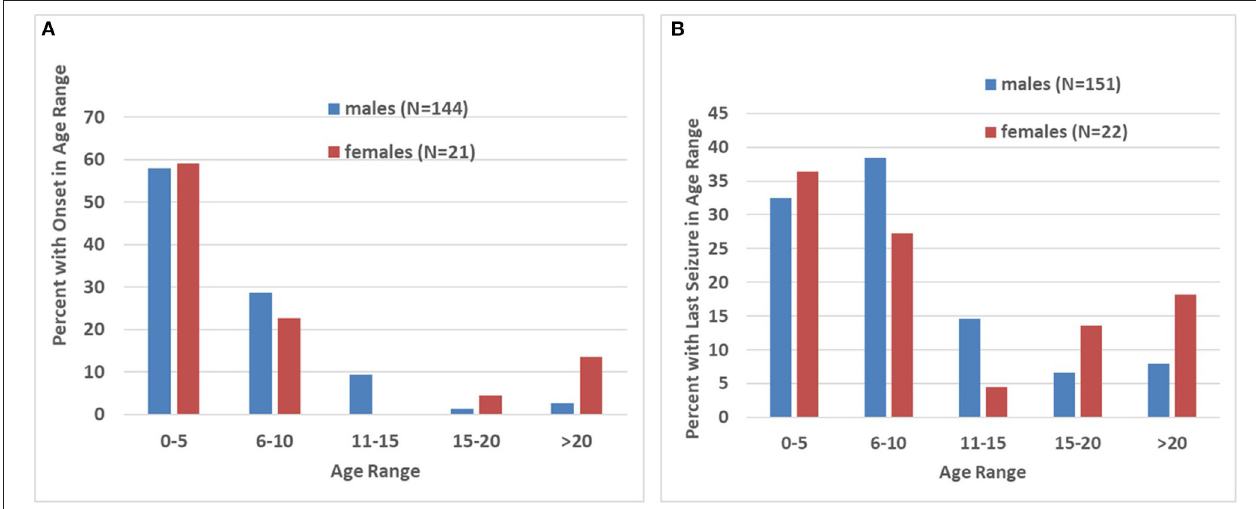
FIGURE 2 | Age of onset and resolution of seizures. (A) Bar graph showing the proportion (in percentages) of individuals, divided by sex, with onset of seizures at different 5 year bins. Note that, with exception of a subset of females with onset after age 15, most patients with FXS displayed an onset before age 10. (B) Bar graph showing the proportion (in percentages) of individuals, divided by sex, experiencing last seizures at different 5 year bins. As for seizure onset, most patients had their last seizure before age 15, with exception of a subset of females who has seizure resolution after this age.